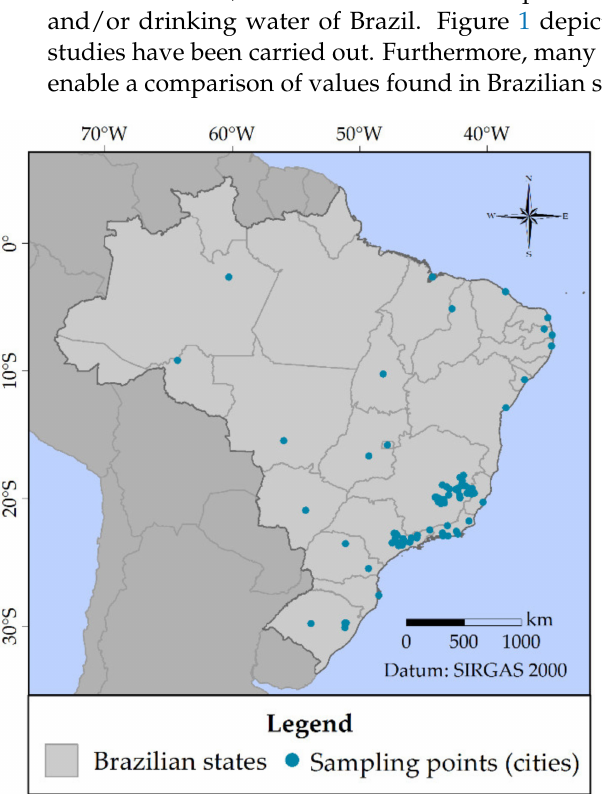
Figure 1. Sampling sites of the monitoring studies surveyed to compile data on occurrence of P&EDC compounds in Brazilian natural and drinking